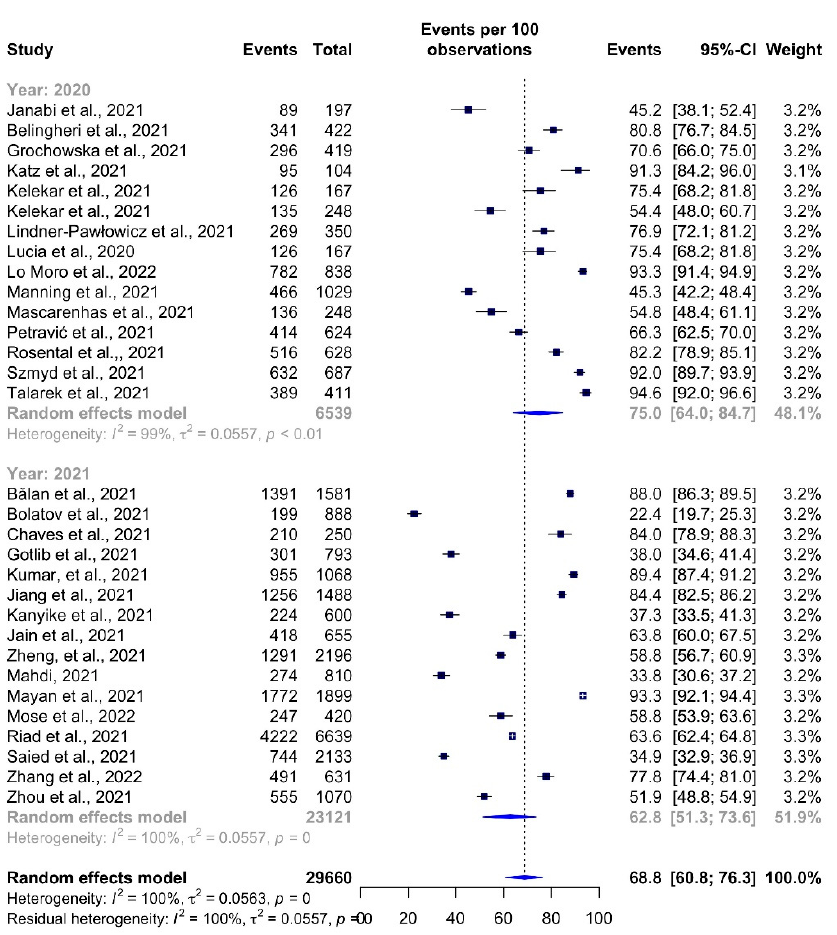
Figure 7. COVID-19 vaccine acceptance rates among healthcare students by year.